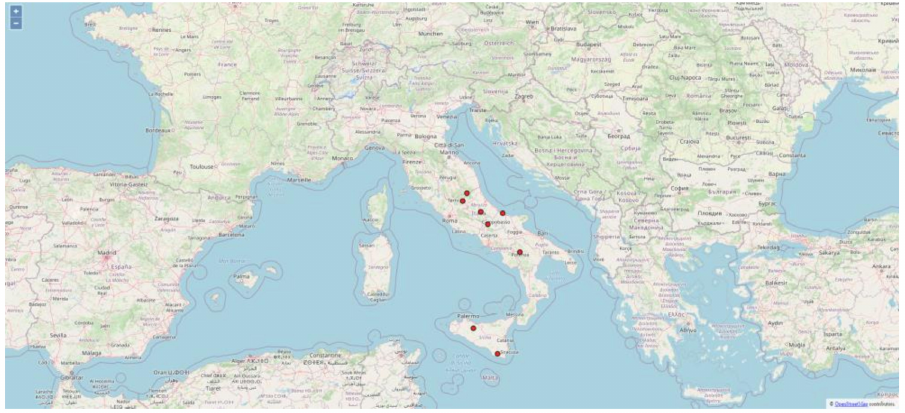
Figure 27. Two-dimensional display